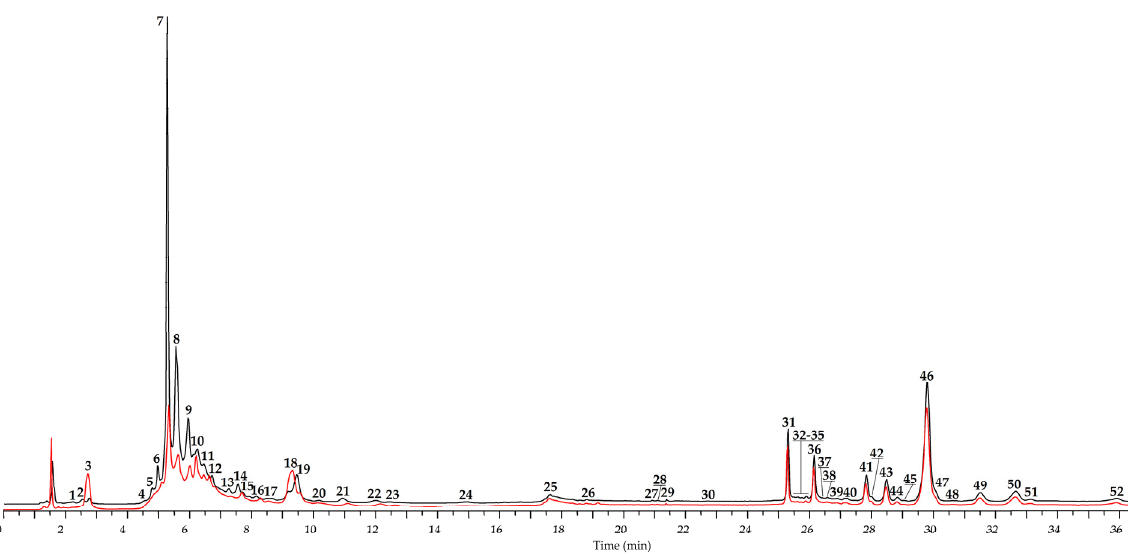
Figure 2. High-performance liquid chromatography with photodiode array detection (HPLC-PDA) chromatogram (270 nm) of E. angustifolium leaves before (black) and after fermentation (red). Compounds are numbered as listed in Table 2. Compounds 1 – 59 were found in E. angustifolium leaves before and after fermentation.